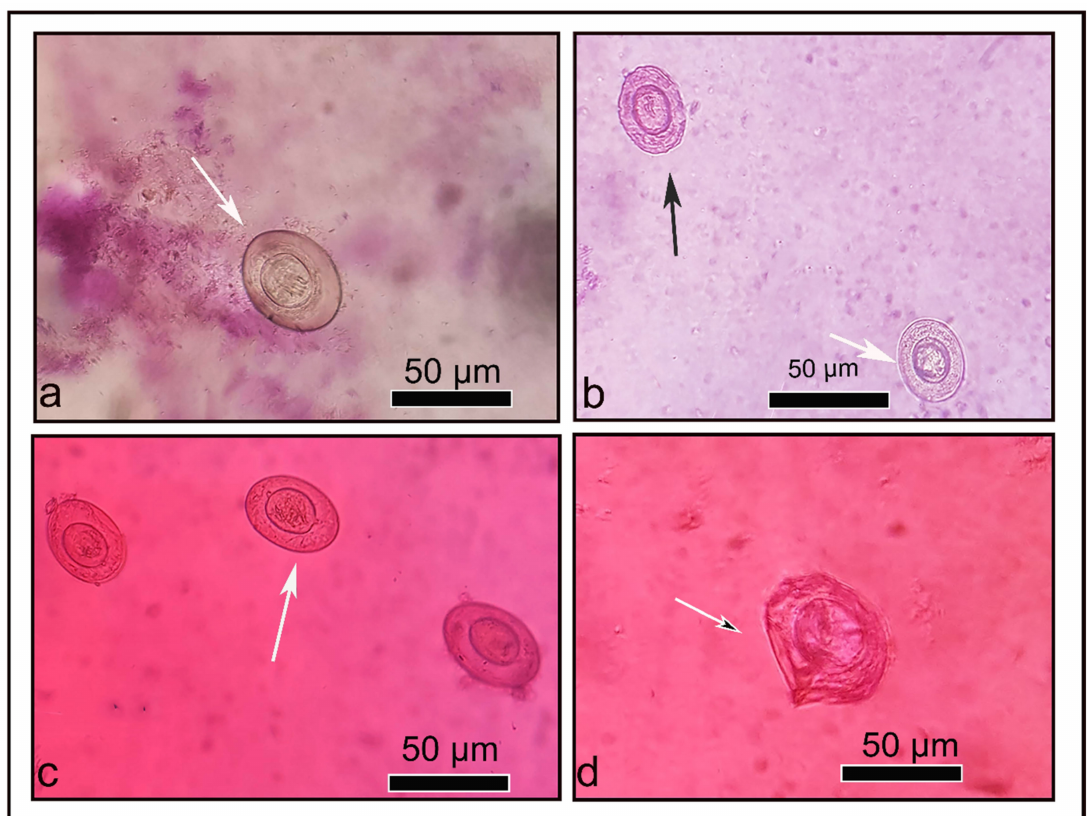
Figure 6. Ovicidal activity of crude PRZ and PRZ-PMMs against H. nana eggs. ( a ) viable non-stained untreated eggs. ( b ) crude PRZ (50 µ g/mL) treated eggs, non-viable red stained eggs (black arrow) and viable non-stained eggs (white arrow). ( c ) PRZ-PMMs (25 µ g/mL) treated eggs, non-viable red stained. ( d ) PRZ-PMMs (50 µ g/mL) treated eggs, non-viable red stained and destructed shell.